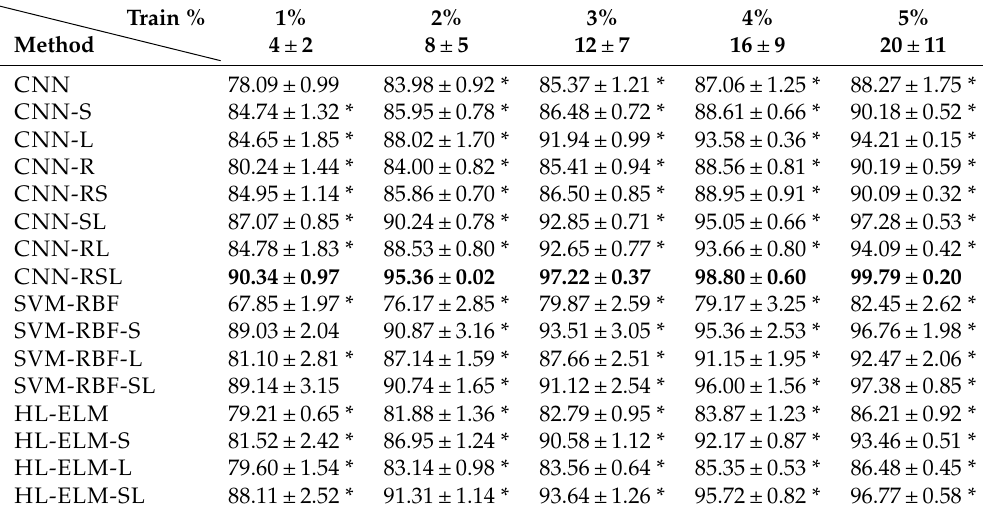
Table 5. Test set classification accuracy on the KSC dataset, when using 1–5% randomly sampled labeled pixels per class for training. We report the mean and standard deviation over 10 runs. We also list the mean and standard deviation of the number of training pixels per class for each training %. The best accuracy for each training set is indicated in bold. An ‘*’ means that the best accuracy is significantly better than the accuracy achieved by the corresponding method according to a binomial test for comparing classifiers [45] ( p -value < 0.05).